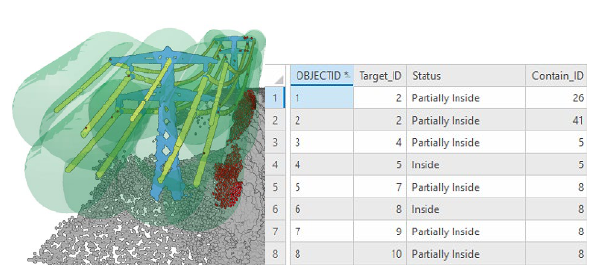
Table 3. User, producer, overall accuracy and kappa coefficient of the test data (in percentage - %).